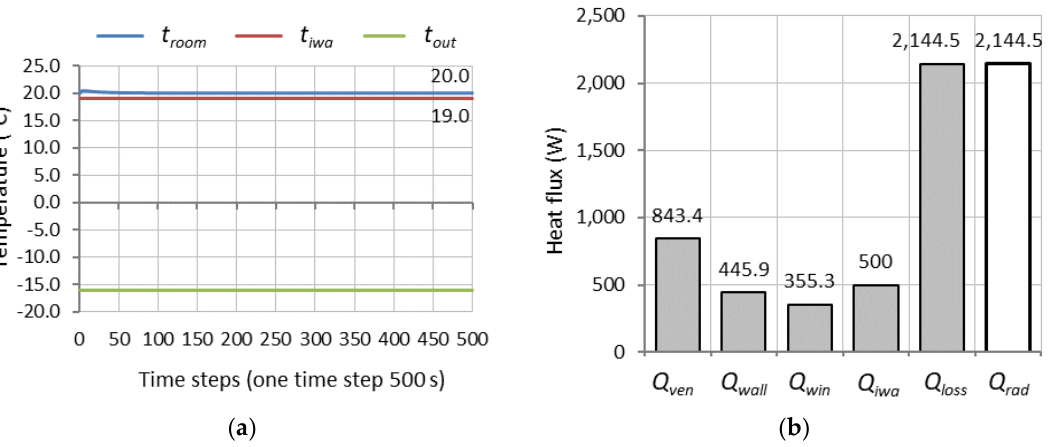
Figure 8. ( a ) Outside, room, and inner wall temperature; ( b ) Ventilation, transmission wall, transmission windows, internal wall flux, total losses (grey data bars), and radiator flux (white data